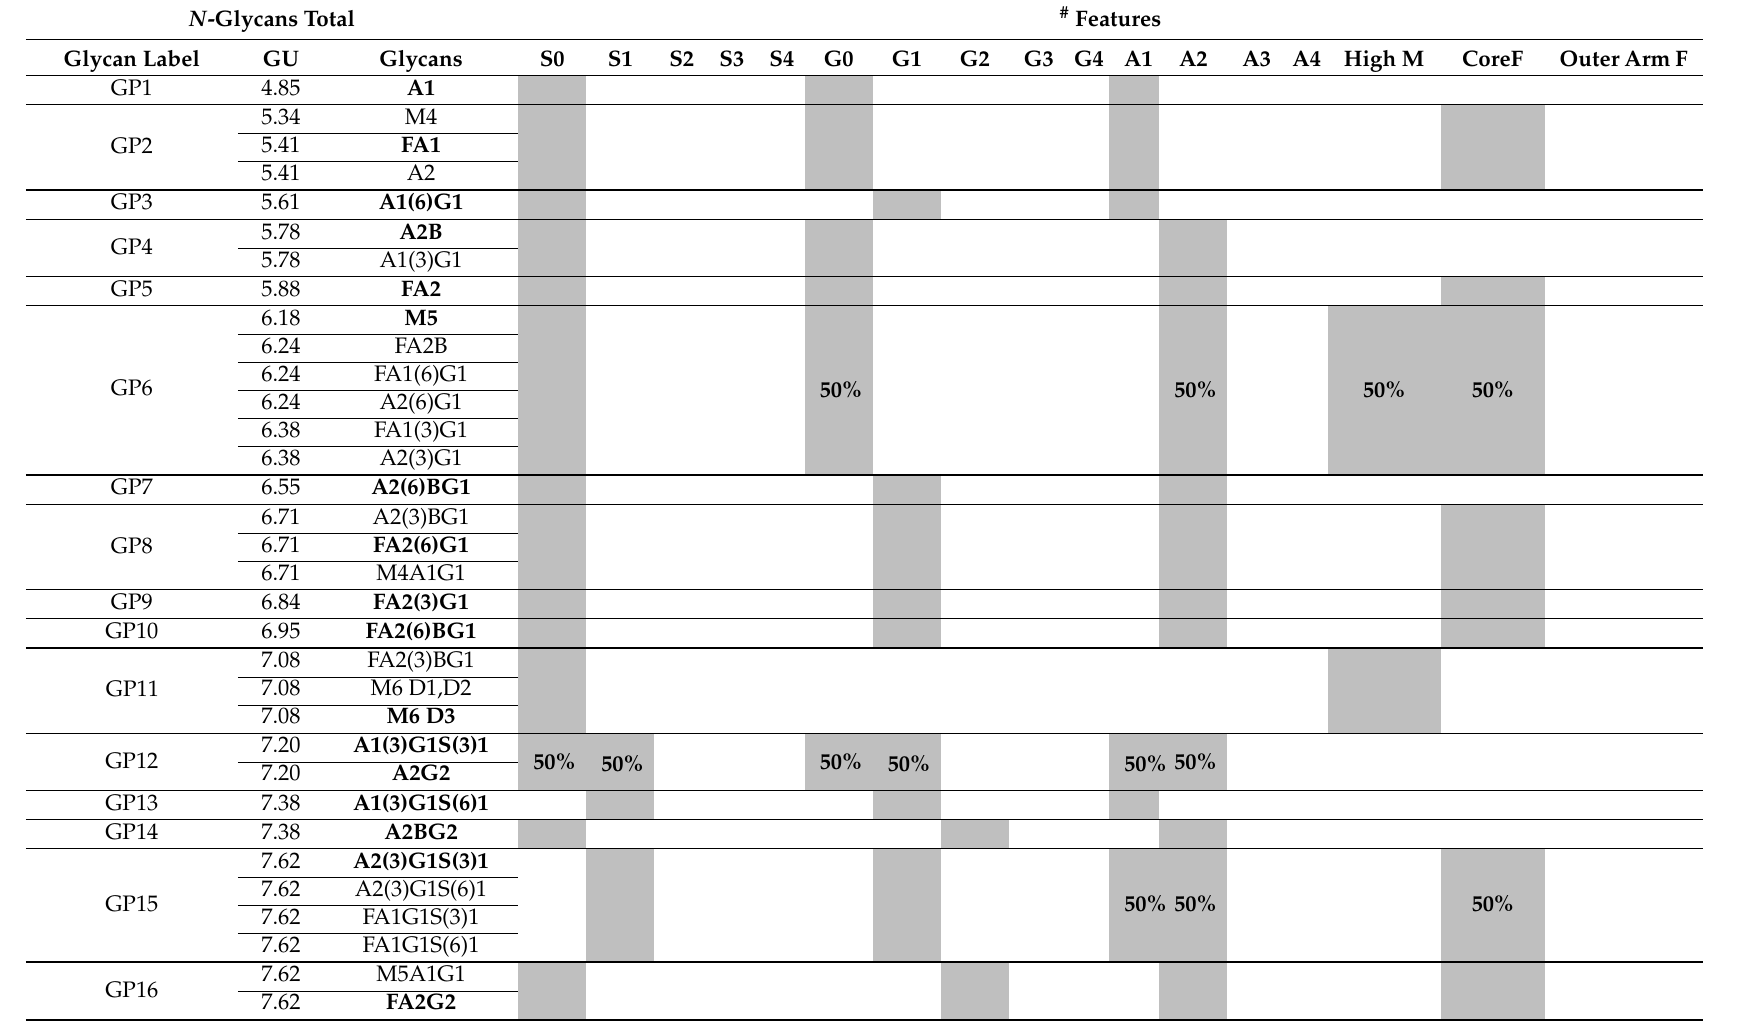
Table 2. Summary of identified N -glycans from prostate cancer